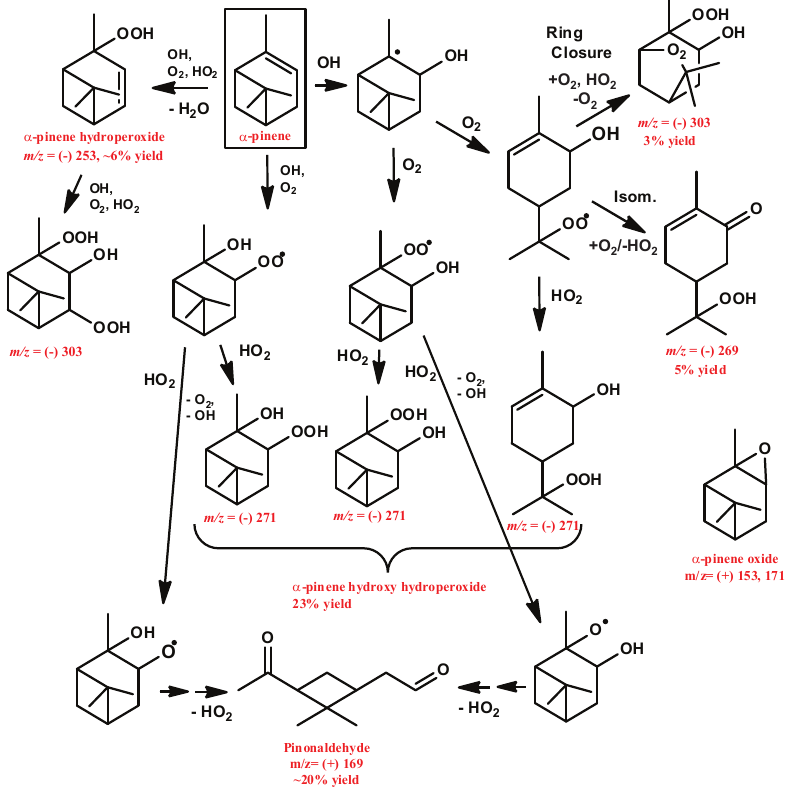
Fig. 1. Pathway of photooxidation of α -pinene under low-NO x conditions. Species that were observed are labeled in red. The m/z of all species observed in the negative mode are of the complex with CF 3 O − (molecular mass+85). Pinonaldehyde is observed at molecular mass +1 in the positive mode and α -pinene oxide is observed at molecular mass +1 and +19. The observed percent yield for first-generation products is also